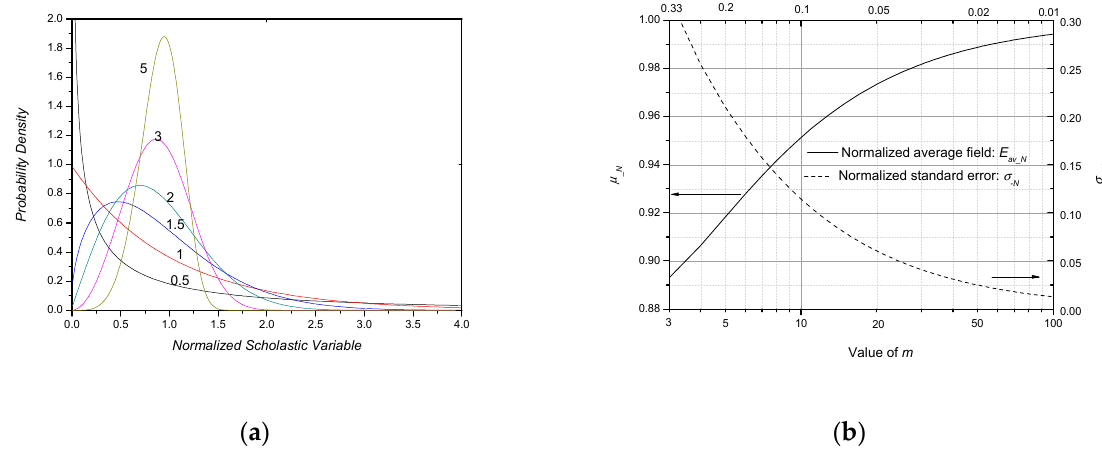
Figure 14. Weibull distribution for different values of m . ( a ) Breakdown probability density v.s. scholastic variable for different m ; ( b ) normalized expectation and standard error of Weibull distribution dependent on m .